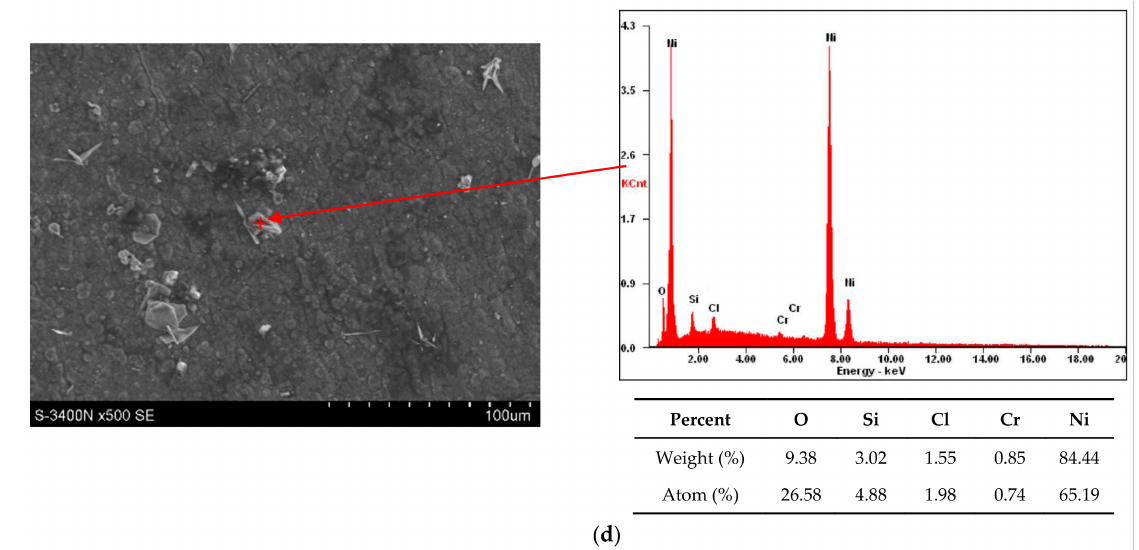
Figure 9. Results of microanalysis of the chemical composition of corrosion products after high- temperature corrosion resistance tests at 800 ◦ C for 1000 h of flame-sprayed coatings: ( a ) Eutalloy ®